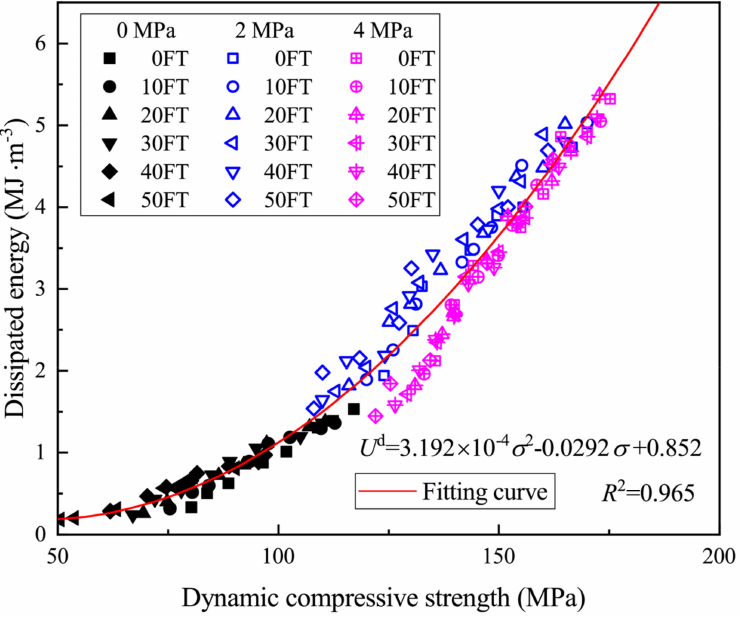
Figure 14. Dissipated energy vs. dynamic compression